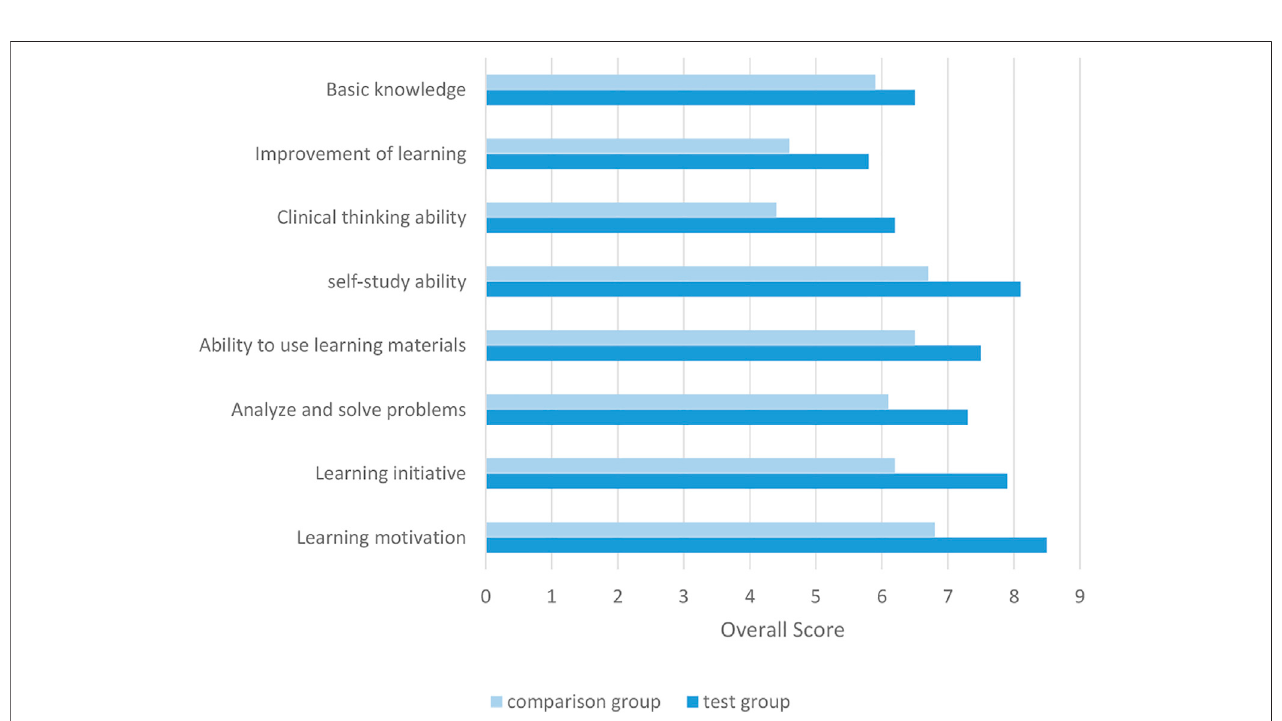
FIGURE 5 | Comparison of the improvement of the two groups of students ’ learning ability by two different teaching methods.